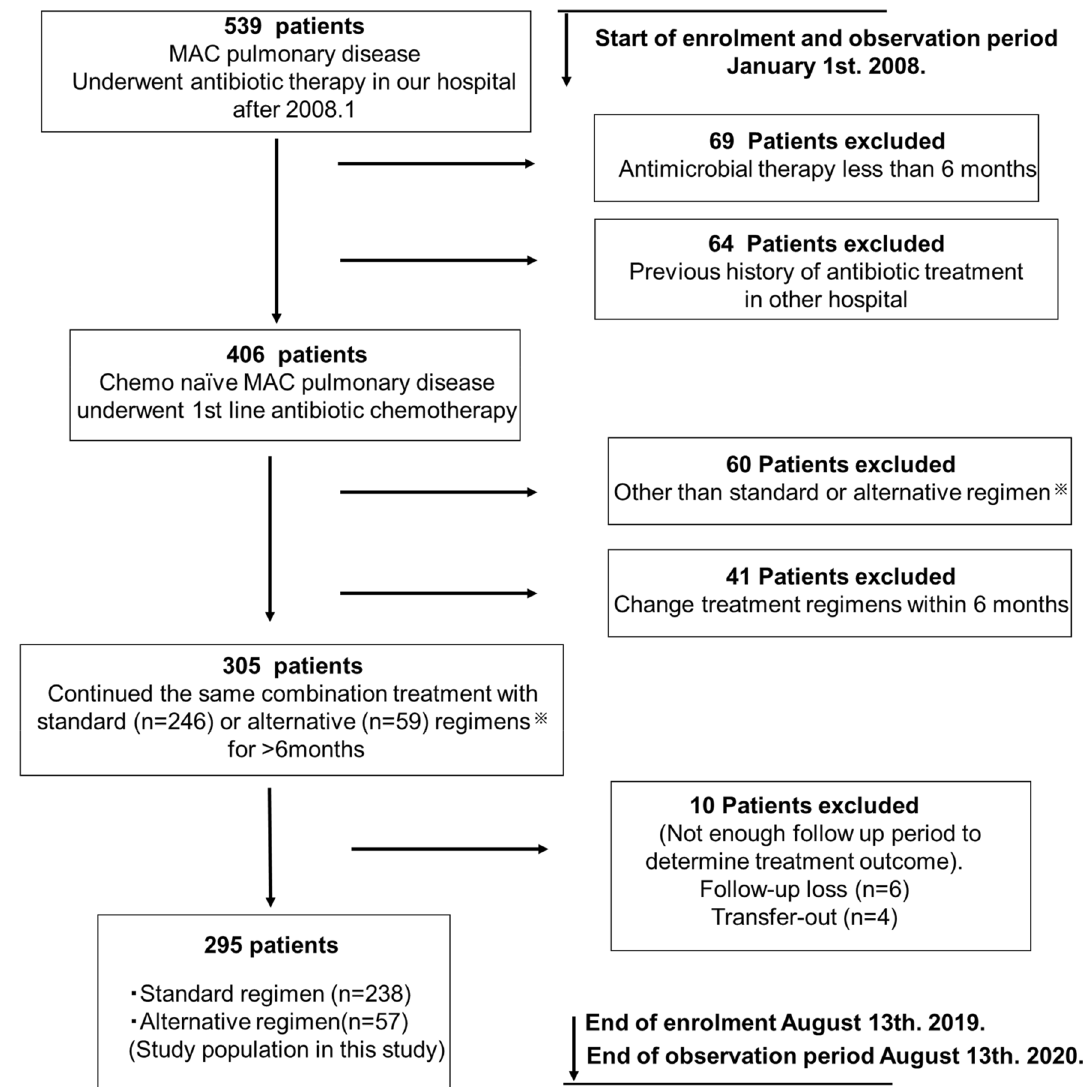
Figure 1. Study design. Patients were included if they were ≥ 20 years old, met the American Thoracic Society/Infectious Diseases Society of America criteria for Mycobacterium avium complex pulmonary disease (MAC-PD), no previous history of antibiotic treatment, and administration of the same combination therapy with standard or alternative regimens for 6 months or longer. Standard regimen: rifampicin (RFP) + ethambutol (EB) + clarithromycin (CAM); alternative regimen: EB + CAM ± fluoroquinolones (FQs) or RFP + CAM +